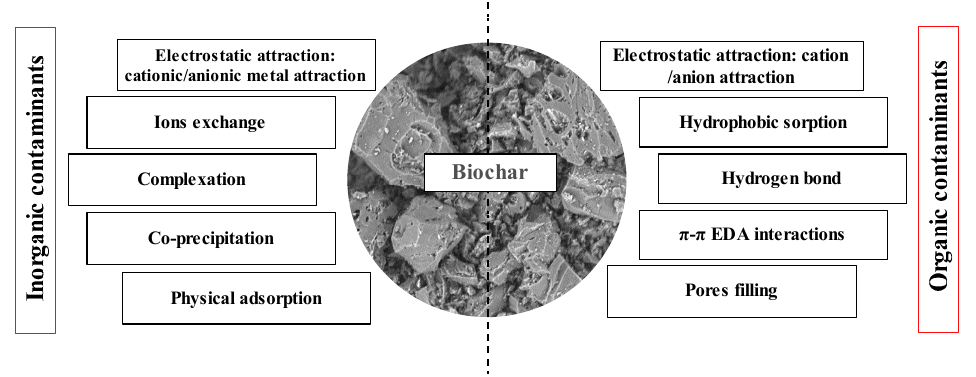
Figure 2. The proposed mechanisms for the removal of organic and inorganic contaminants by biochar.